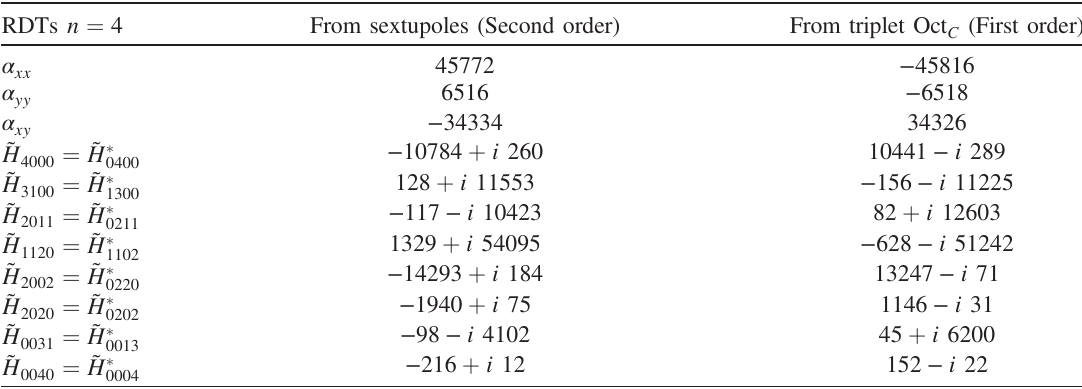
TABLE I. Table of the fourth-order RDTs generated to the second order by the chromatic sextupoles and to the first order by the octupole triplet Oct simultaneously and systematically